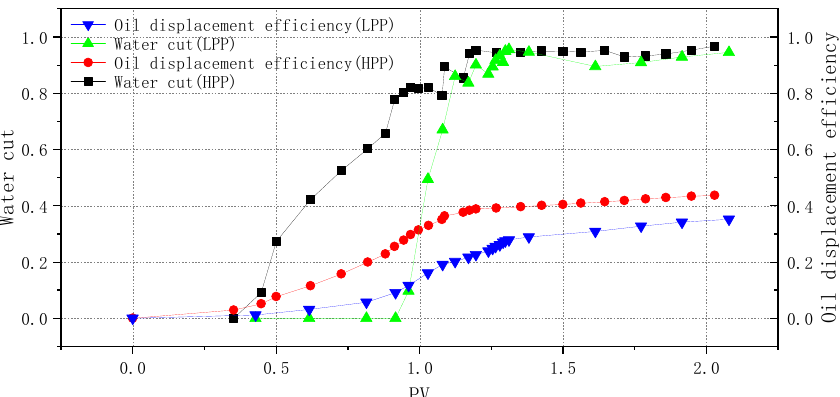
Figure 3. Comparison curves of oil repelling efficiency and water content of high and low permeability pipes (same oil sample).